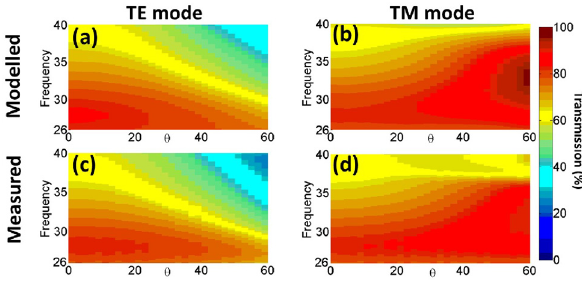
Figure 10: Modelled data showing the angular dependence of RF transmission for incident TE (a) and TM (b) polarization along with the measured RF transmission for TE (c) and TM (d)